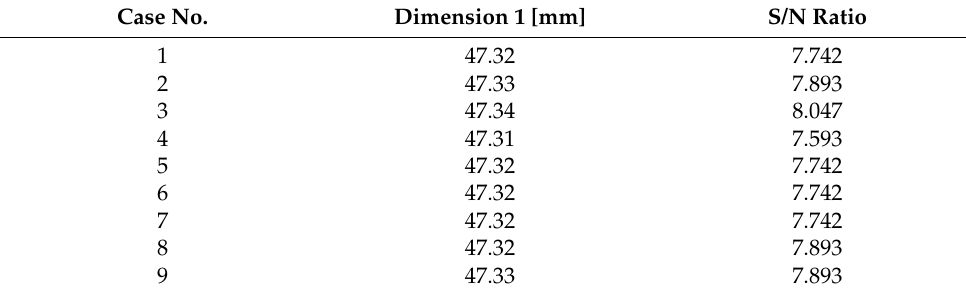
Table 13. S/N ratio of measurement 1 for pivot sub-assembly.